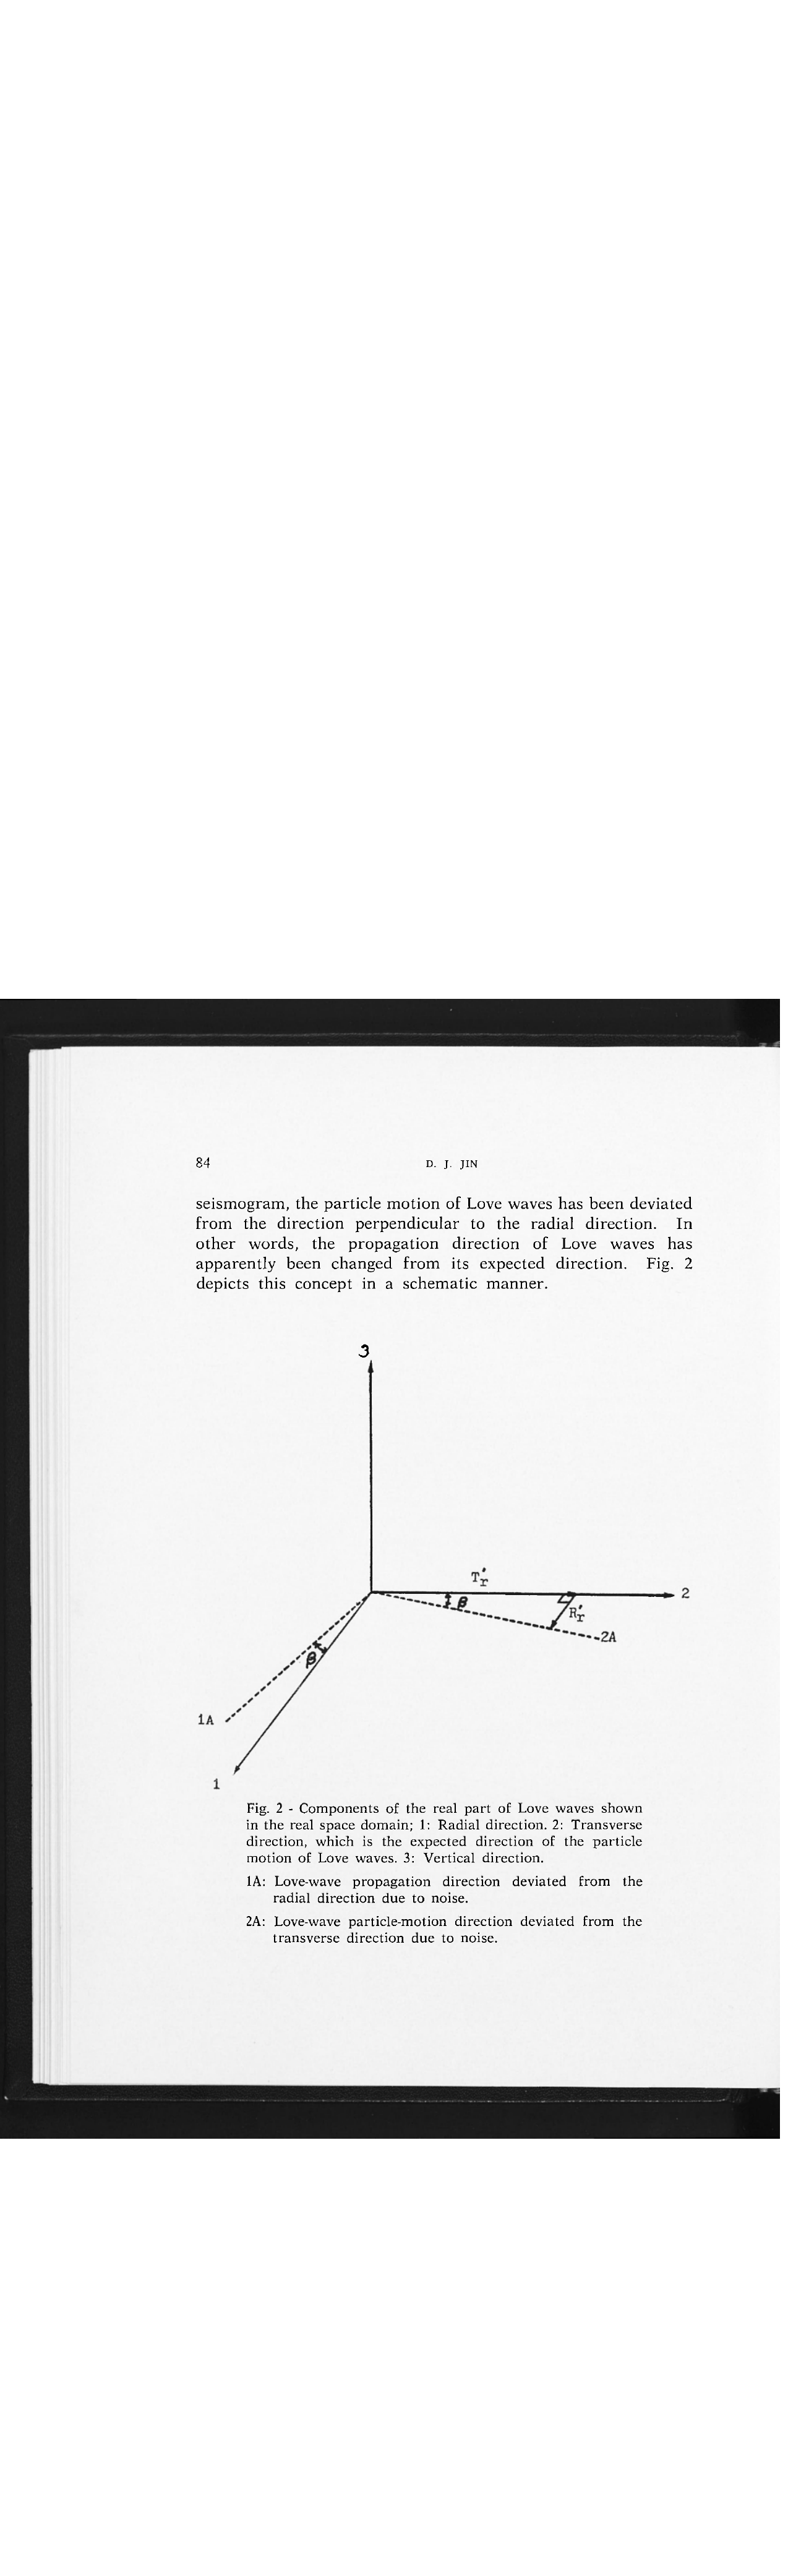
Fig. 2 - Components of the real part of Love waves